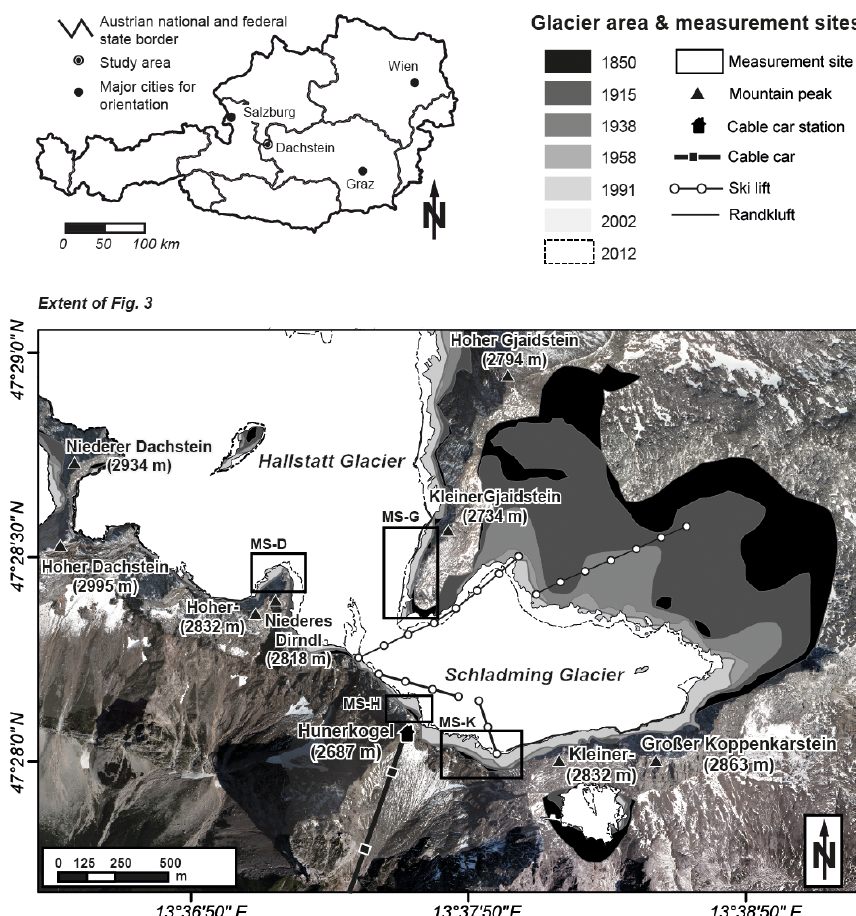
Figure 1. Location of the study area Dachstein Massif in Austria, and an overview map depicting the four different measurement sites within the study area. Glacier recession between ca. 1850 (LIA maximum) and 2012 is indicated. Abbreviations: MS-D, measurement site Dirndln; MS-G, measurement site Gjaidstein; MS-H, measurement site Hunerkogel; MS-K, measurement site Koppenkarstein. Orthophoto in the background by the province of Upper Austria,